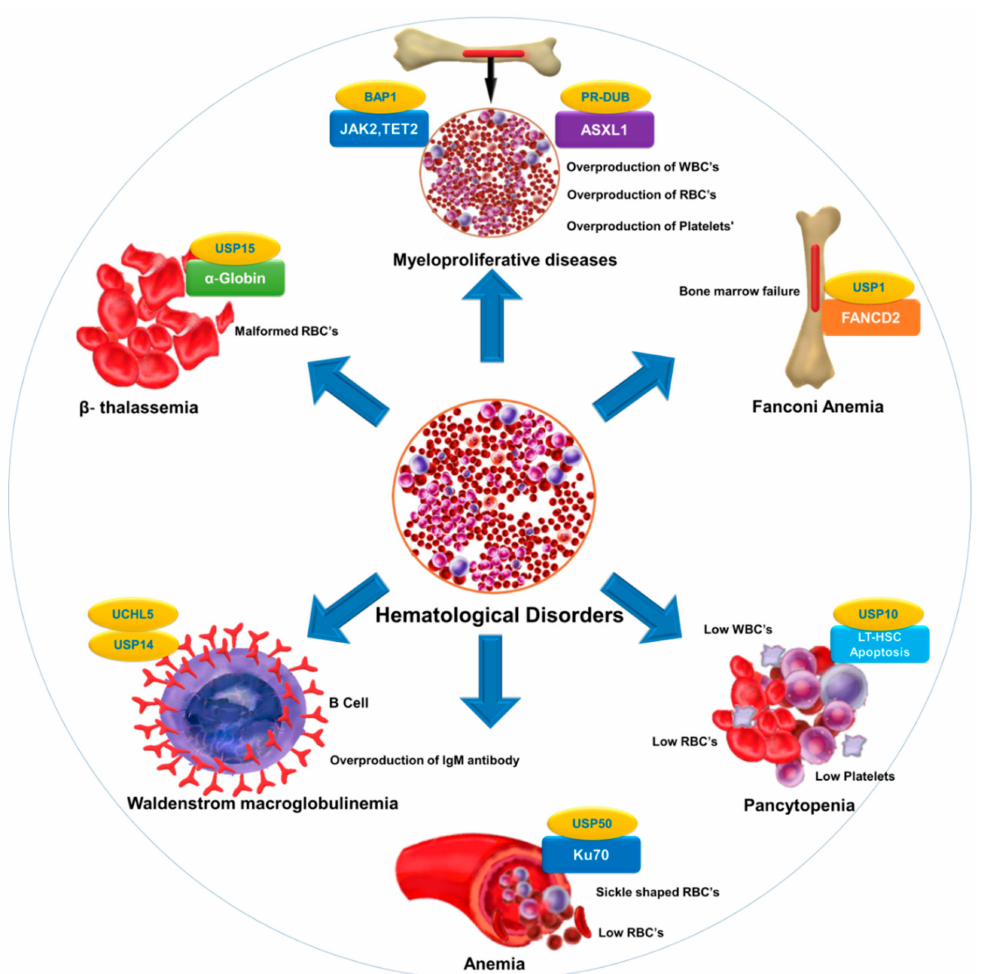
Figure 2. DUB as a novel target in hematological diseases. DUBs regulate the level and function of a protein by catalyzing removal of ubiquitin from the substrate protein. Dysregulation of DUBs contributes to the pathogenesis of various hematological disorders. The figure illustrates di ff erent hematological disorders and the associated DUBs that can provide novel targets for therapeutic interventions to treat these